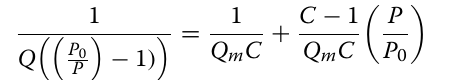
Fig. 6 a N 2 adsorption–desorption analysis isotherm (inset showing a relation between relative pressure ( P / P 0 ) versus 1/[ Q ( P 0 / P pore size distribution plot of activated carbon materials (inset shows magnified view demonstrating the existence of mesopores for